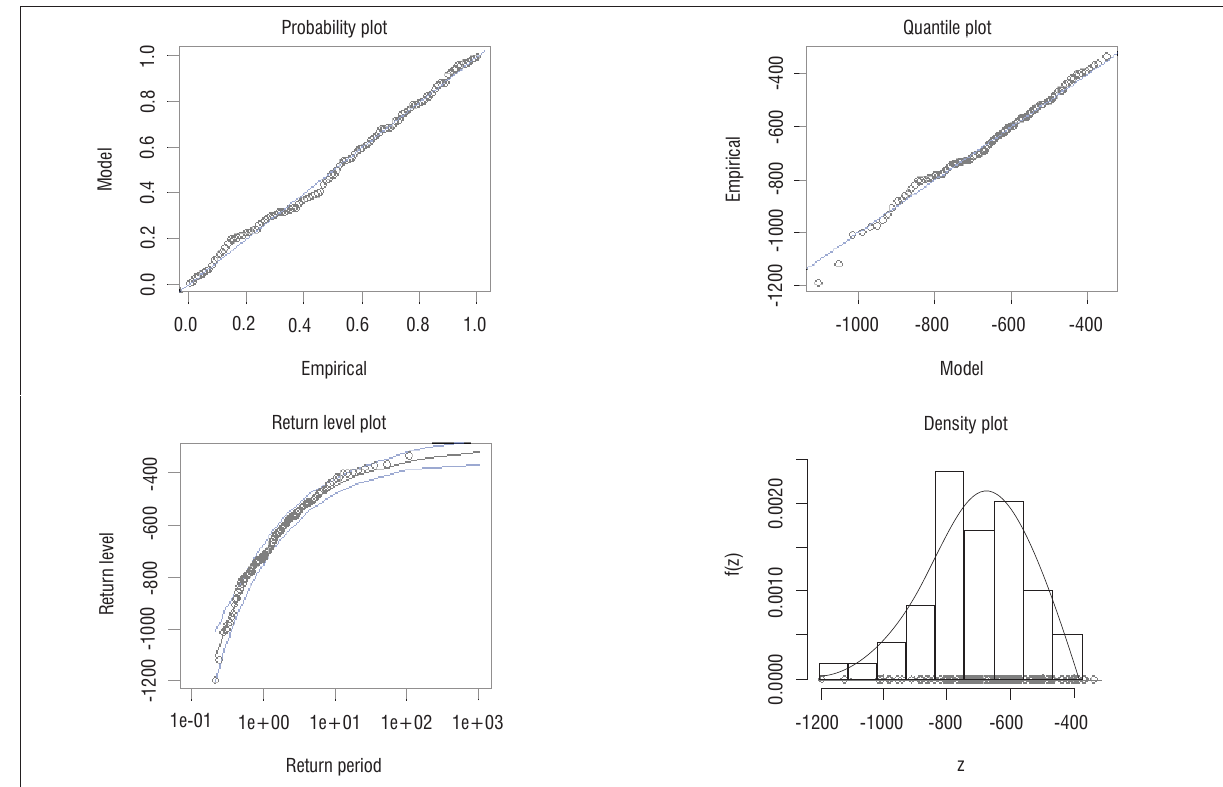
The generalised extreme value probability density function of minima annual rainfall for Zimbabwe for the period